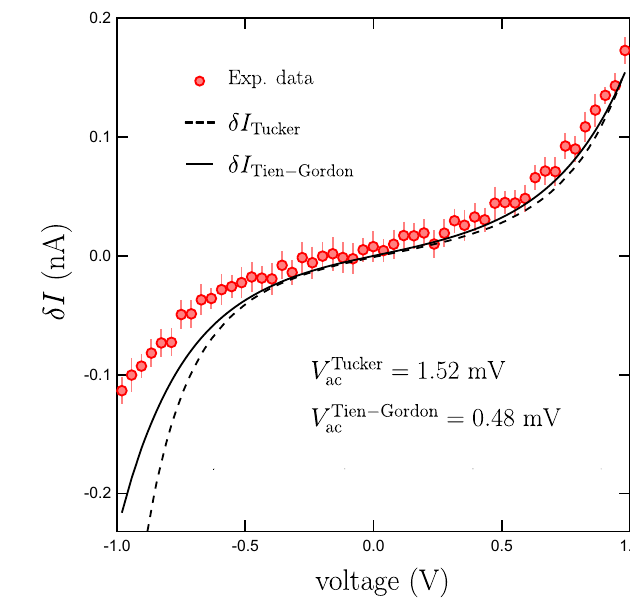
Fig. 3 Reponsivity of the metallic tunnel junction. Normalized photon- assisted current δ I (PAT) / P abs for laser power ranging between 11 mW and 53 mW. The width of the laser spot on the sample is w laser = 650 μ m. The measurement is performed at base temperature T 0 = 2.8 K at the surface plasmon resonance α res ¼ (cid:2) 39 (cid:4) . Inset bottom right: I ( V ) and I ( V ± V 0 ) characteristics of the tunnel junction measured at low temperature T = 2.8 K. The fi t of I ( V ) with the Simmons theory gives d = 1.6 nm, 0 U = 2.9 eV and Δ U = − 0.78 eV. 0 0